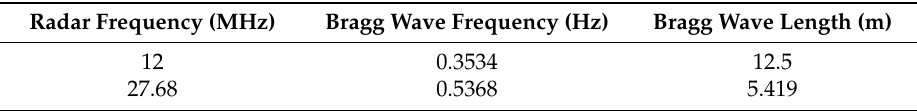
Table 3. Radar frequencies and corresponding Bragg